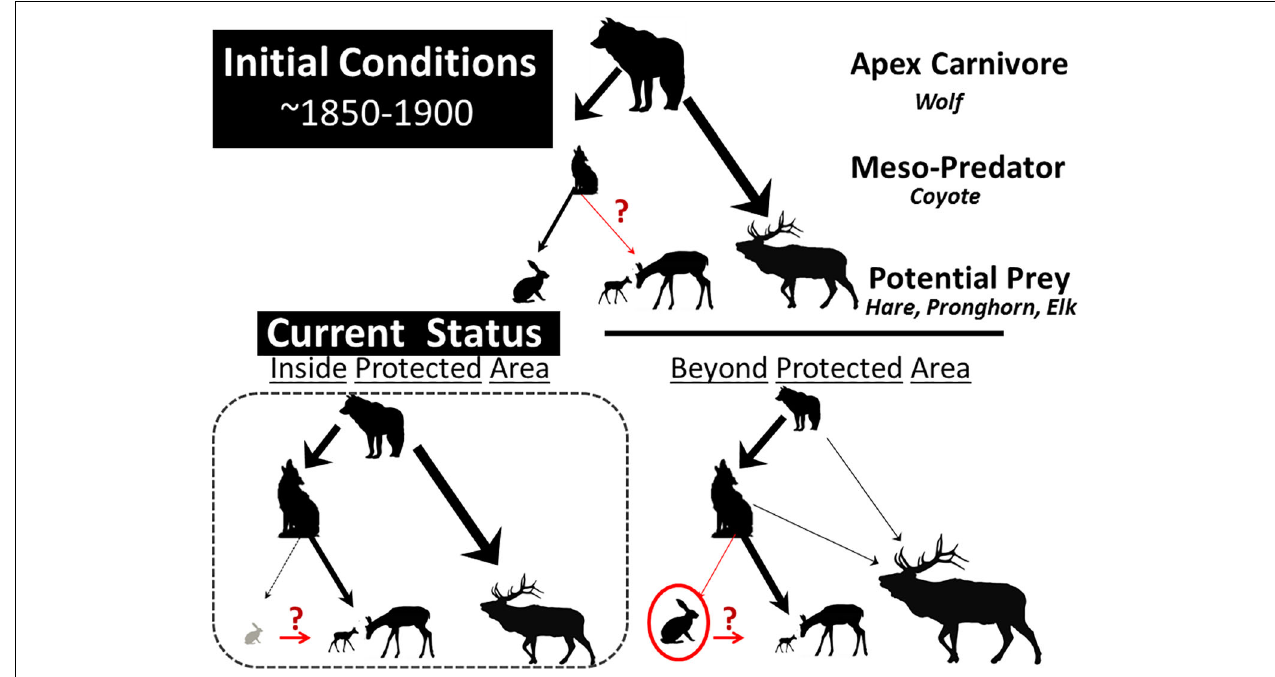
FIGURE 3 | Schematic of temporal change in a prey–predator food web in a protected area of the Greater Yellowstone Ecosystem (Wyoming) spanning about 150 years. The top illustration reflects wolf, coyote, elk, pronghorn, and white-tailed jackrabbits. The arrow width reflects the strength of predation intensity. The relative size of the icons depicts a positive or a negative relationship, and the red notation reflects